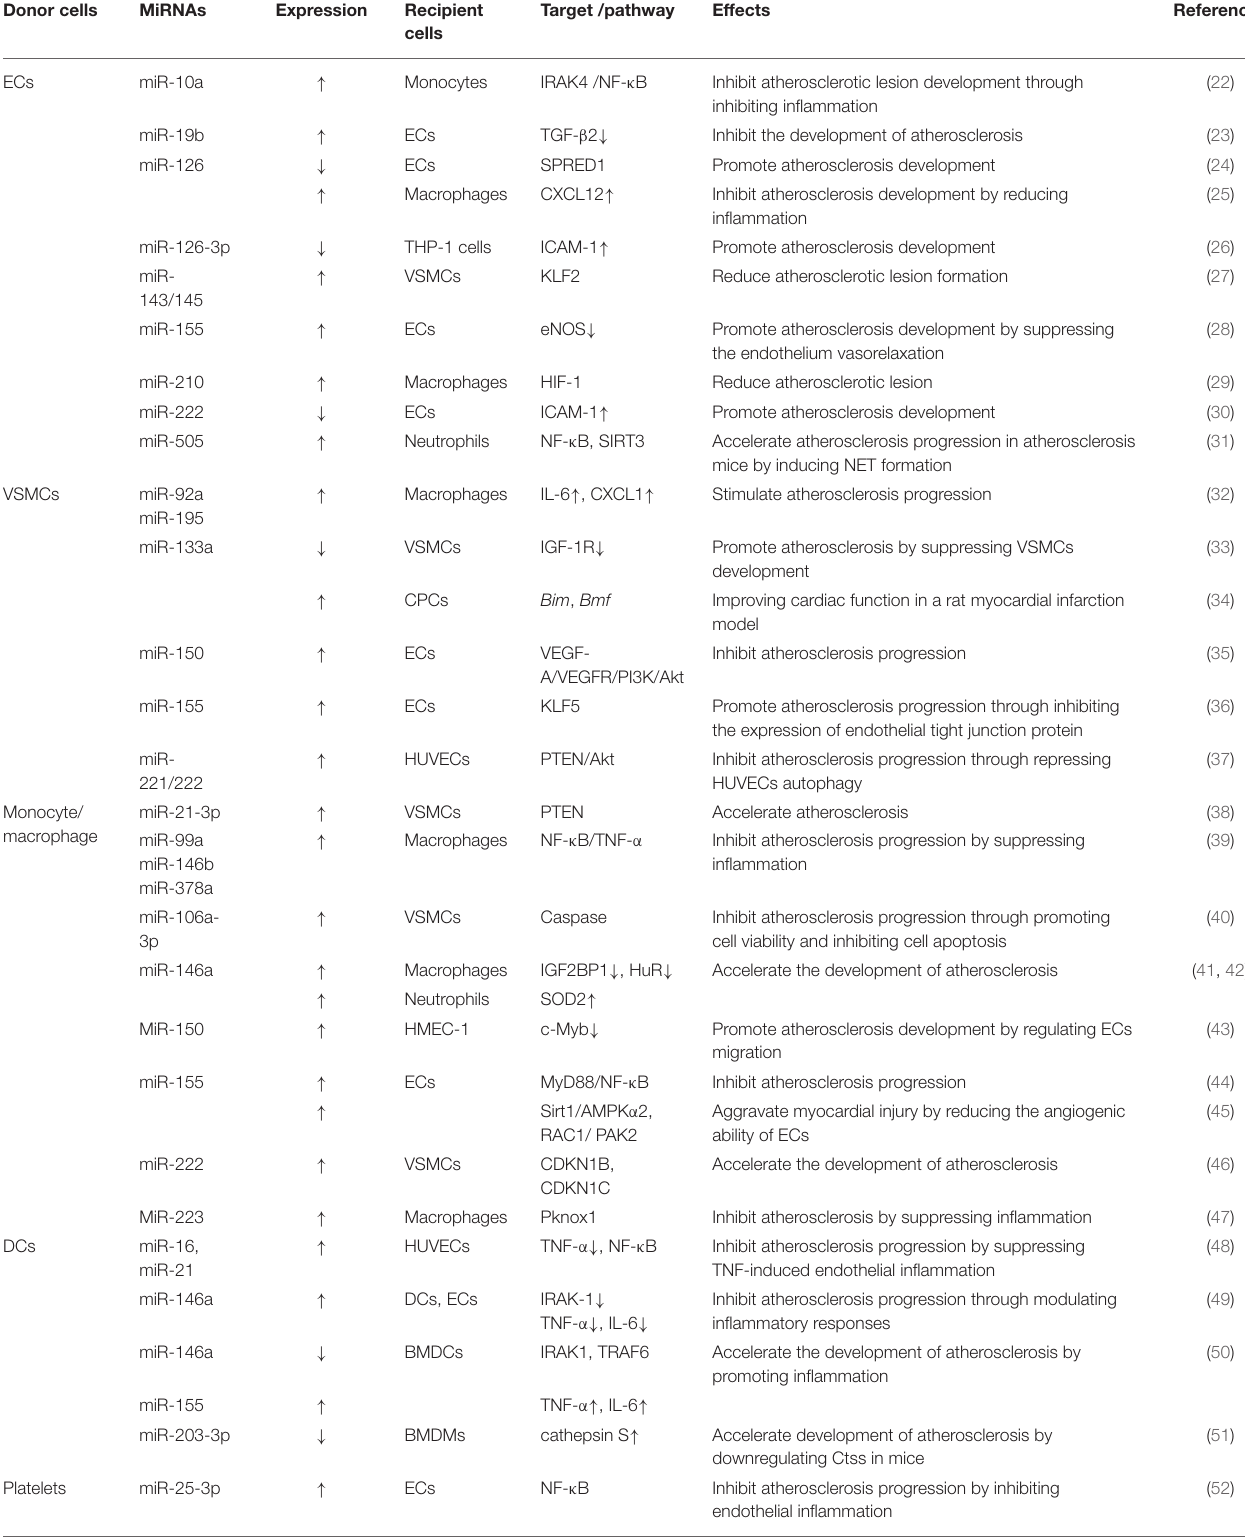
TABLE 1 | Function of miRNAs in EVs in atherosclerosis. Donor